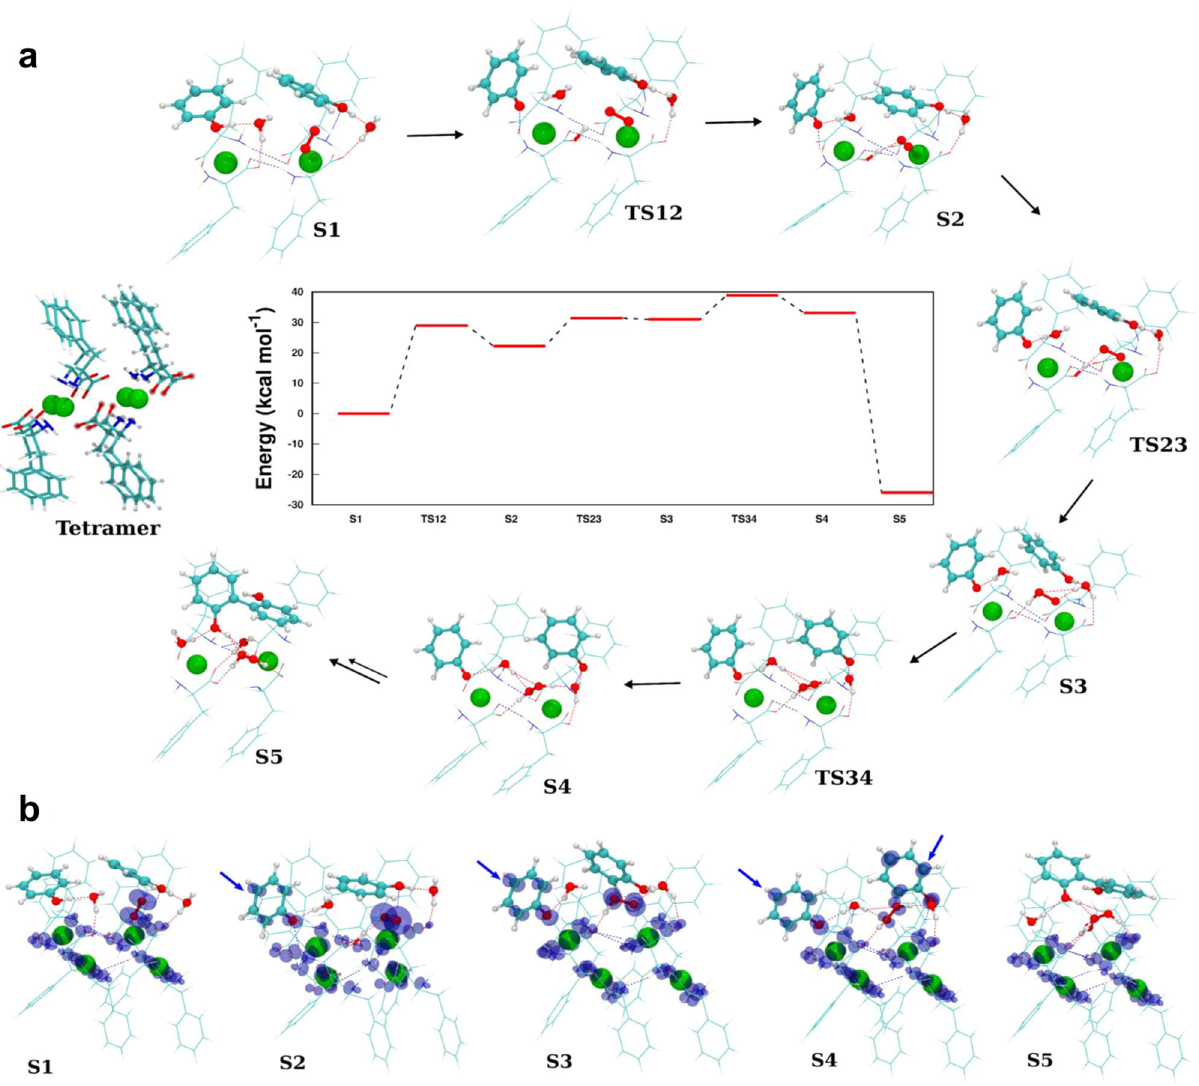
Fig. 5 Reaction pathway for F-Cu catalytic oxidative coupling of phenolic pollutants. a The tetramer model of F-Cu used in the DFT calculations is shown on the left. The atoms displayed as transparent beads in the tetramer were held fi xed throughout the calculations to emulate periodic crystal effects. Relative energies of steps 1 through 5, with transition state energies scaled with respect to step 1, are shown in the central part of the panel. The optimized structures of all steps are also shown, with fi xed atoms not shown for clarity. b Spin-densities of steps 1 through 5. Spin-densities on the phenyl rings of the phenoxyl radicals are indicated by the blue